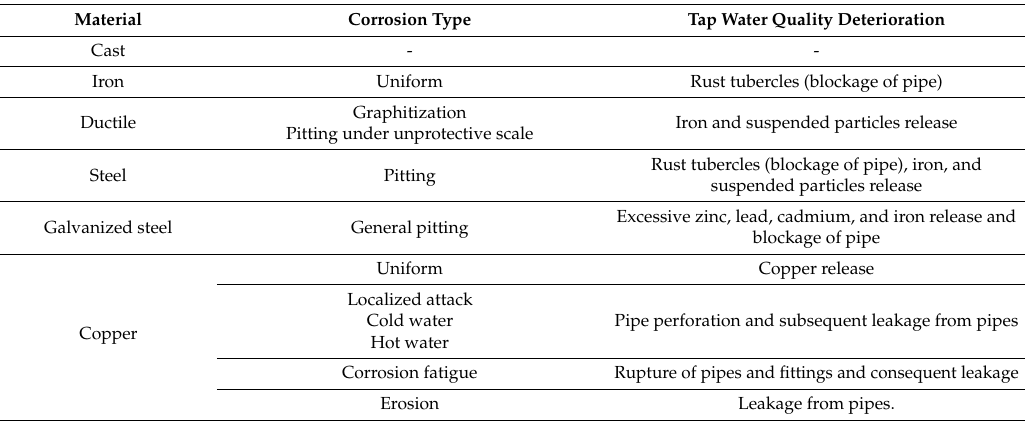
Table 7. Effects of pipe material on internal pipe corrosion.